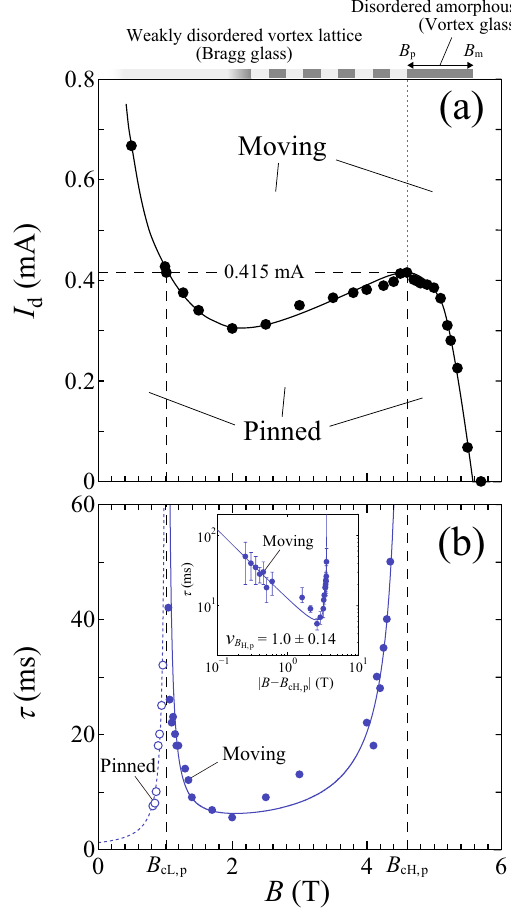
Figure 6. The critical divergence of the relaxation time τ( B ) at the density-driven depinning transition ( B cL , p ) and repinning transition ( B cH , p ). In the high- B region, the pinned phase corresponds to a point at B p . ( a ) The B dependence of I d at 4.1 K, which is the same data as shown in Fig. 2a. A horizontal dashed line marks I d , p 0.415 mA and a full line is a guide to the eye. ( b ) τ obtained from V ( t ) measured under the fixed I d , p mA plotted against B , where open and solid blue circles correspond to the data in the pinned and moving phases, respectively. τ exhibits a power-law divergence at the peak field B p B cL , p ), as indicated with vertical dashed lines in ( a , b ). The inset shows log τ versus log T( ≡ dotted line in the main panel represents the power-law fit by